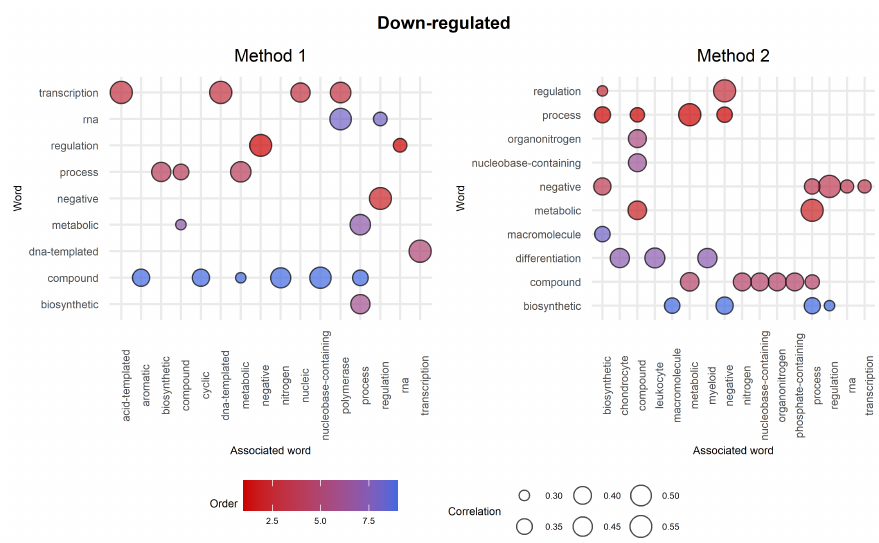
Figure 11. Correlation analysis for the top 10 words. The top 10 most significant words are represented on the y -axis, and their respective associated words are on the x -axis. The colour of the bubbles is based on the order (significance of a given GO term as described in items 1–4 in Section 2.5.2), whilst the size depends on the correlation between words. Note that if two top 10 words A and B are associated with each other, then the plot shows both pairs (A,B) and (B,A).